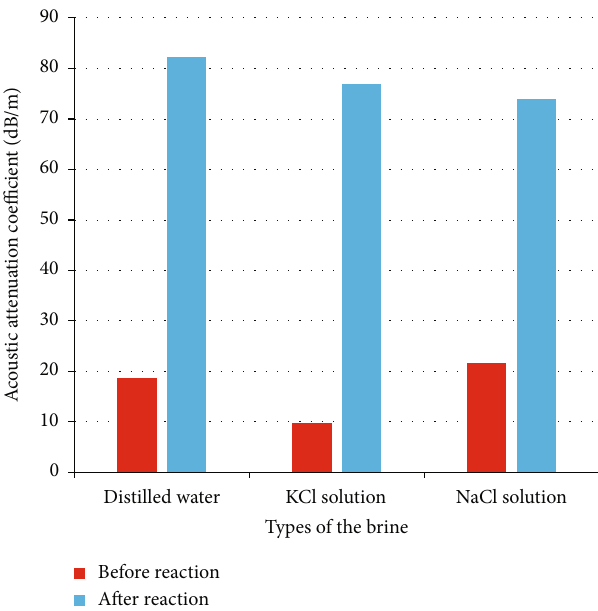
Figure 8: Acoustic attenuation coe ffi cient of shale before and after interaction with di ff erent brine for 48